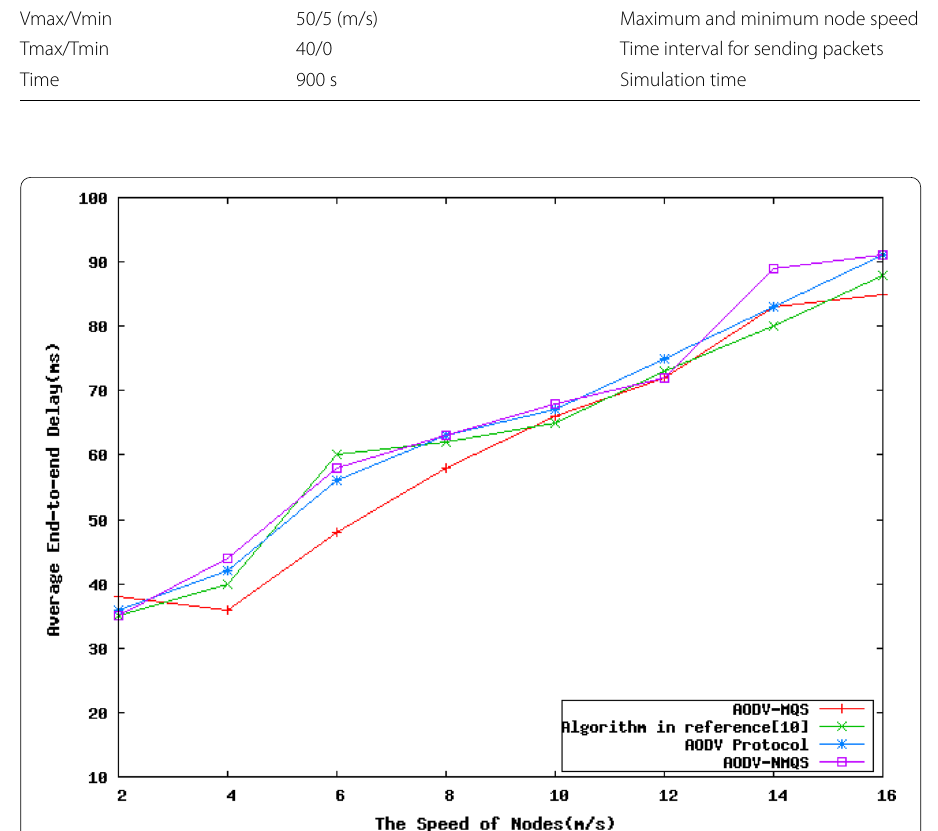
Fig. 6 Comparison of end-to-end delay of four routing algorithms in a safe